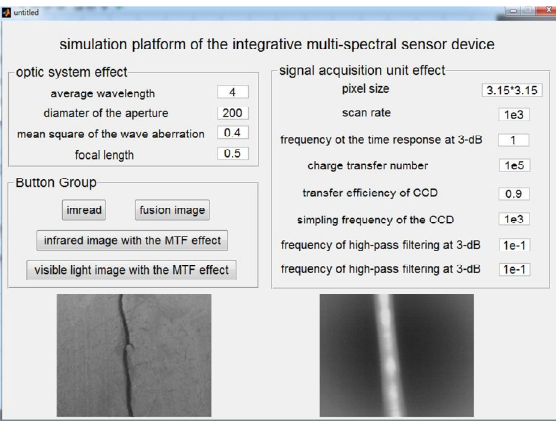
Fig. 6 Simulation flow of the sensor